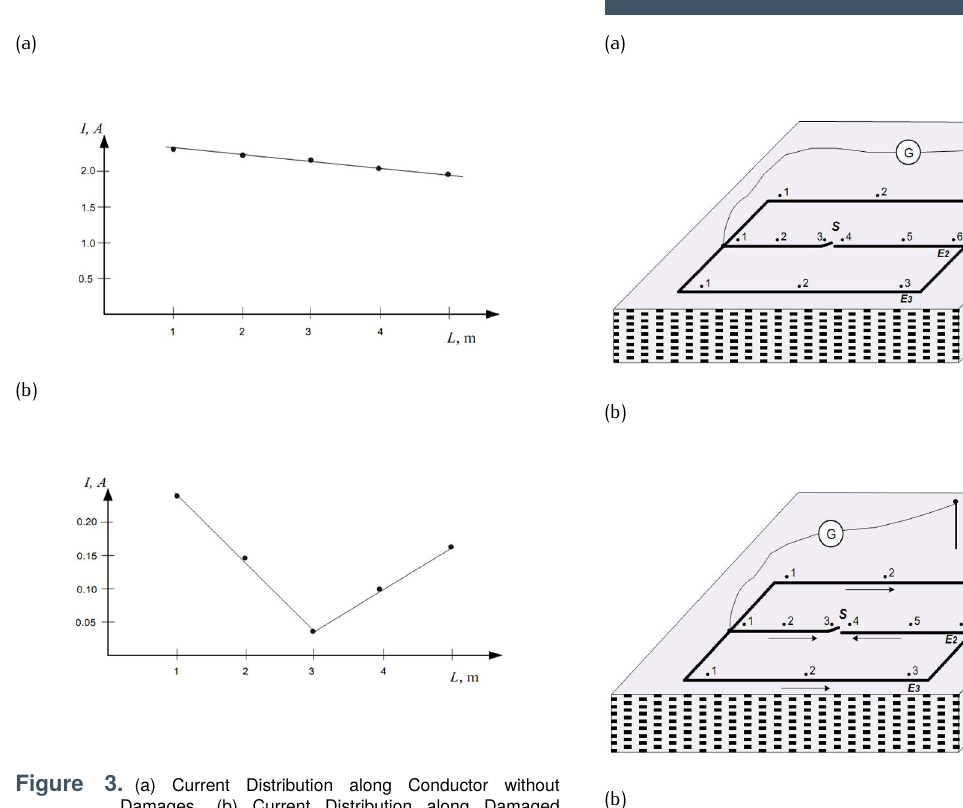
Figure 3. (a) Current Distribution along Conductor without Damages, (b) Current Distribution along Damaged Conductor.